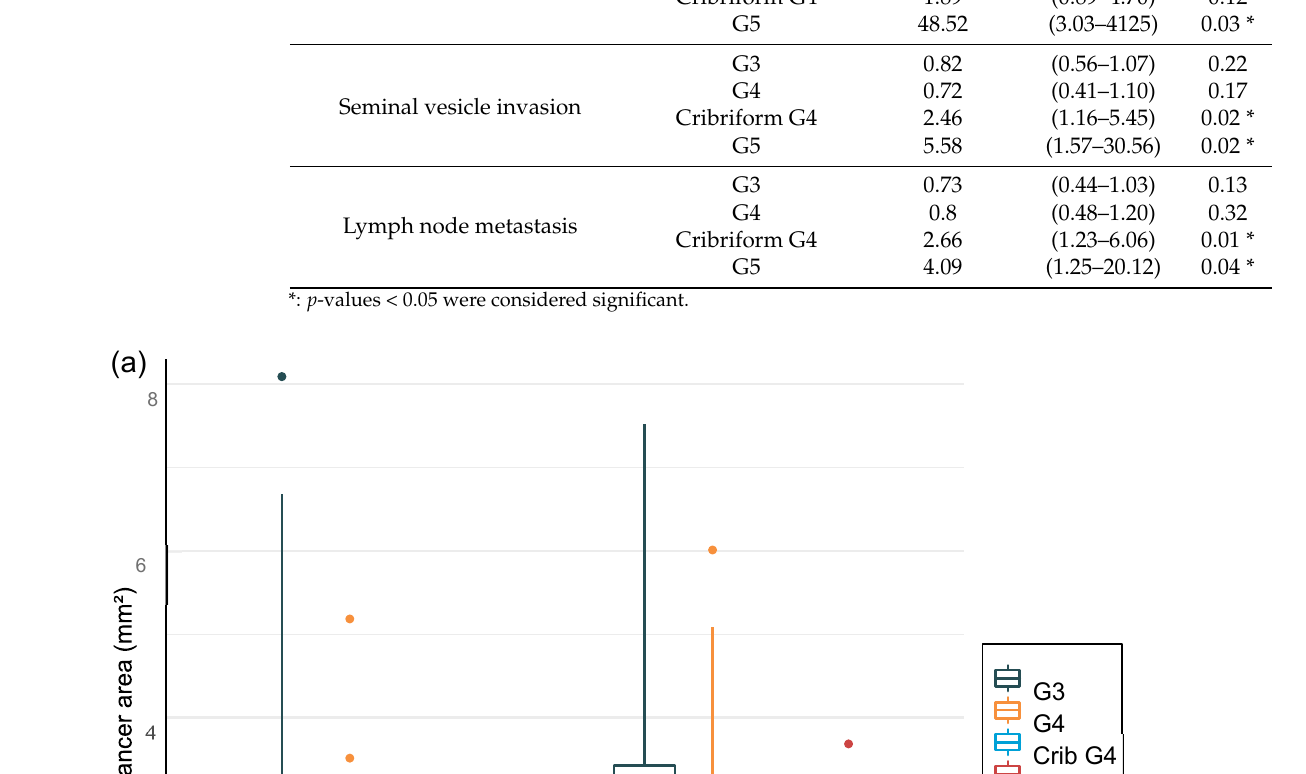
Table 9. Multi-regression models for adverse pathological findings at prostatectomy show a statisti- cally significant correlation between the area of cribriform G4 and G5 for seminal vesicle invasion and lymph node metastasis, as G5 shows high OR for non-organ-confined disease. Clinical Outcome